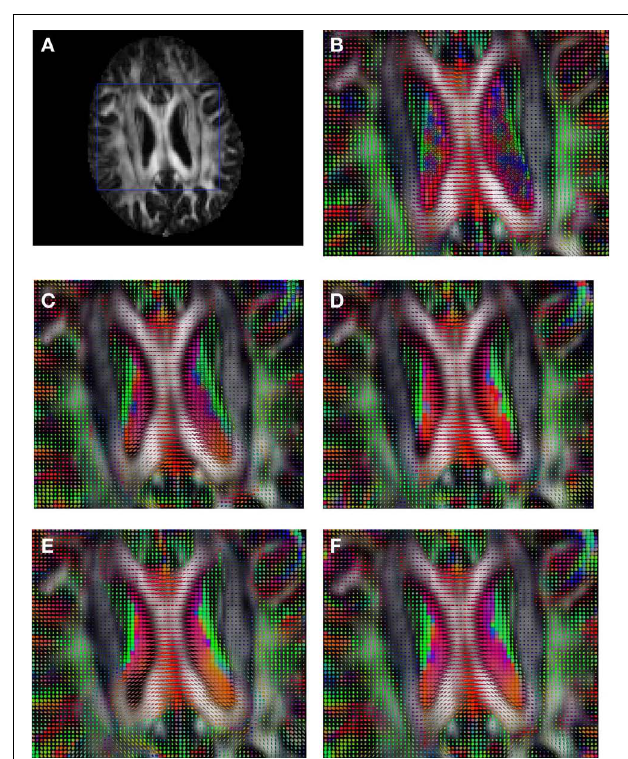
FIGURE 9 | Comparison of the tensors (represented as RGB color coded glyphs) of Subject3 and the tensors of Subject2 registered to Subject3. (A) Subject3 FA indicating the region selected to show the tensors. (B) Subject3 tensors. Registered tensors of Subject2 using (C) FLIRT-volumes-SH, (D) FLIRT4D-AI, (E) MedINRIA-volumes-SH, and (F) DTI-TK-volumes-SH.